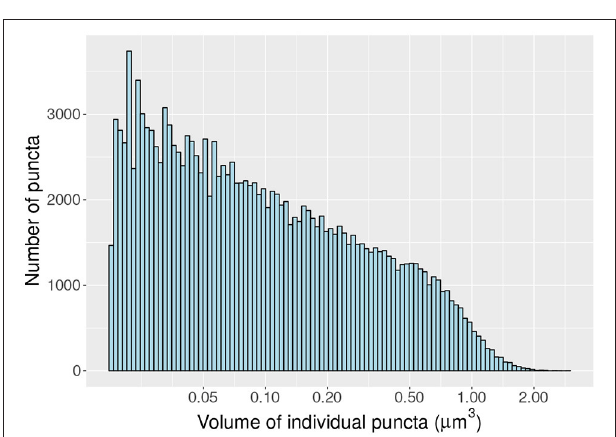
FIGURE 6 | Histogram of volumes (log scale) of individal vGlut-1 puncta in the stratum radiatum of CA1.